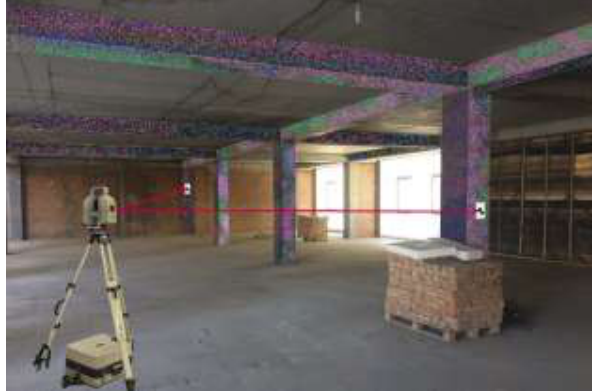
Figure 3 . Spectral deformation zones of columns and floor beams